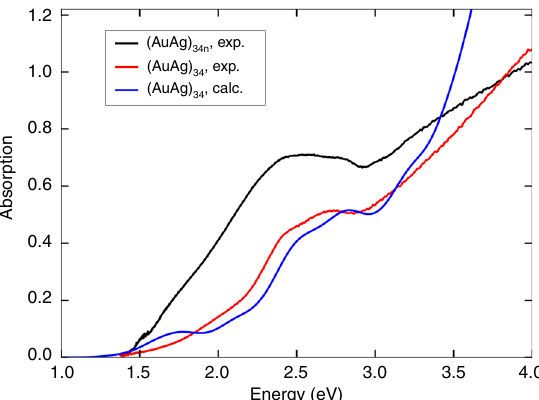
Fig. 6 UV – Vis absorption spectra. Absorption spectra of both monomeric and polymeric crystals. Computed spectrum for one of the isolated (AuAg) 34 L 20 model clusters (see details of the models in the Methods) is shown as well. The intensity of the computed spectrum is scaled to the experimental peak at 2.7 eV of the monomeric cluster but no shifts have been applied in the energy